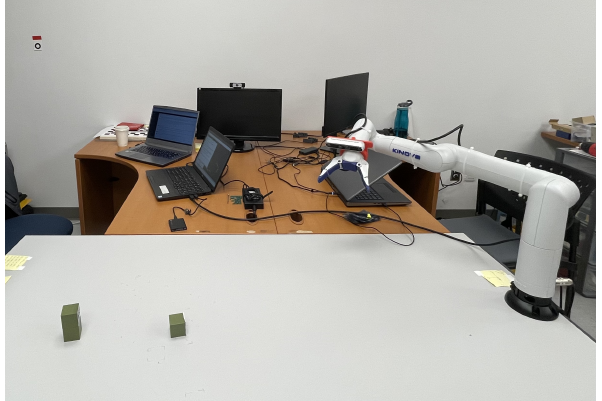
Figure 14. Alternative camera pose used for the sixth scenario, resulting in successful occlusion-free